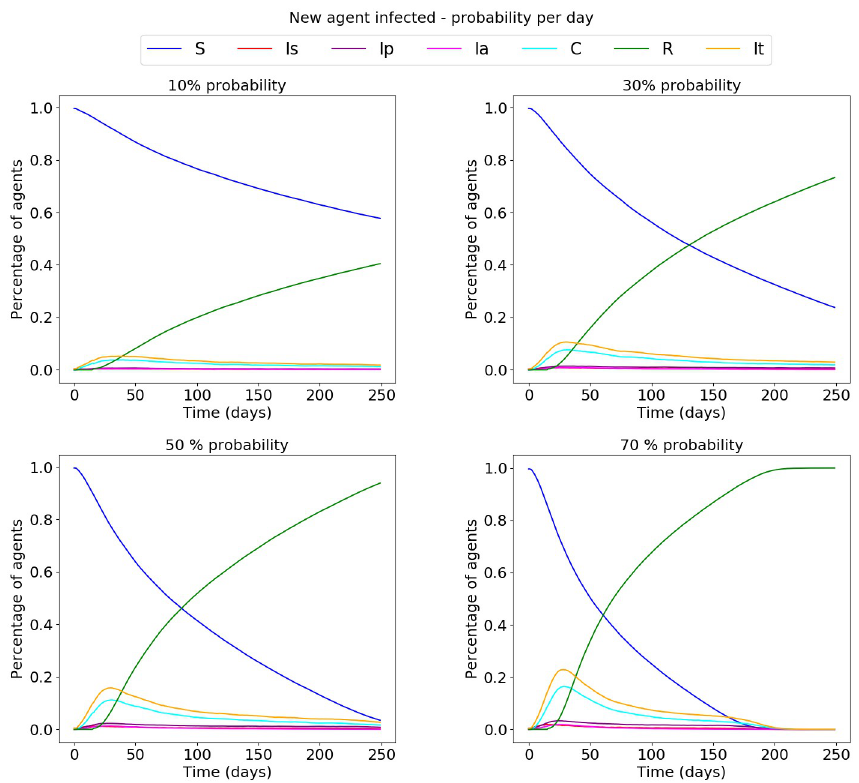
Fig 6. Percentage of nodes in an immunized stage (10, 30 and 60% on Sch1). The agents are selected based on different criteria: A) randomly, B) by its degree, C) by its clustering, and D) by its betweenness.